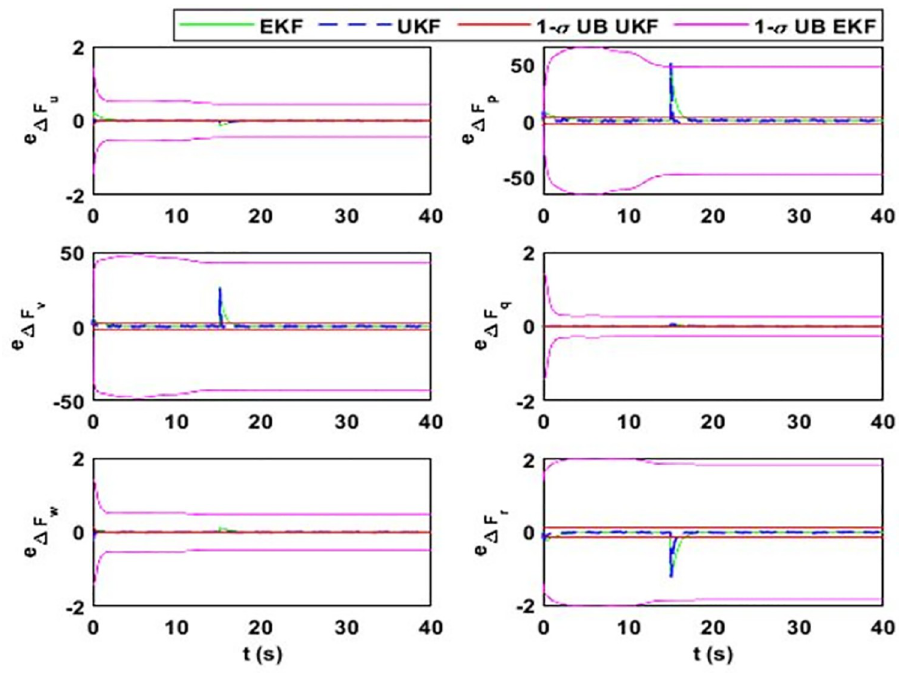
Fig 6. Estimation error and error bounds for lumped uncertainty vector showing the error and sigma bounds corresponding to (i) Δ F